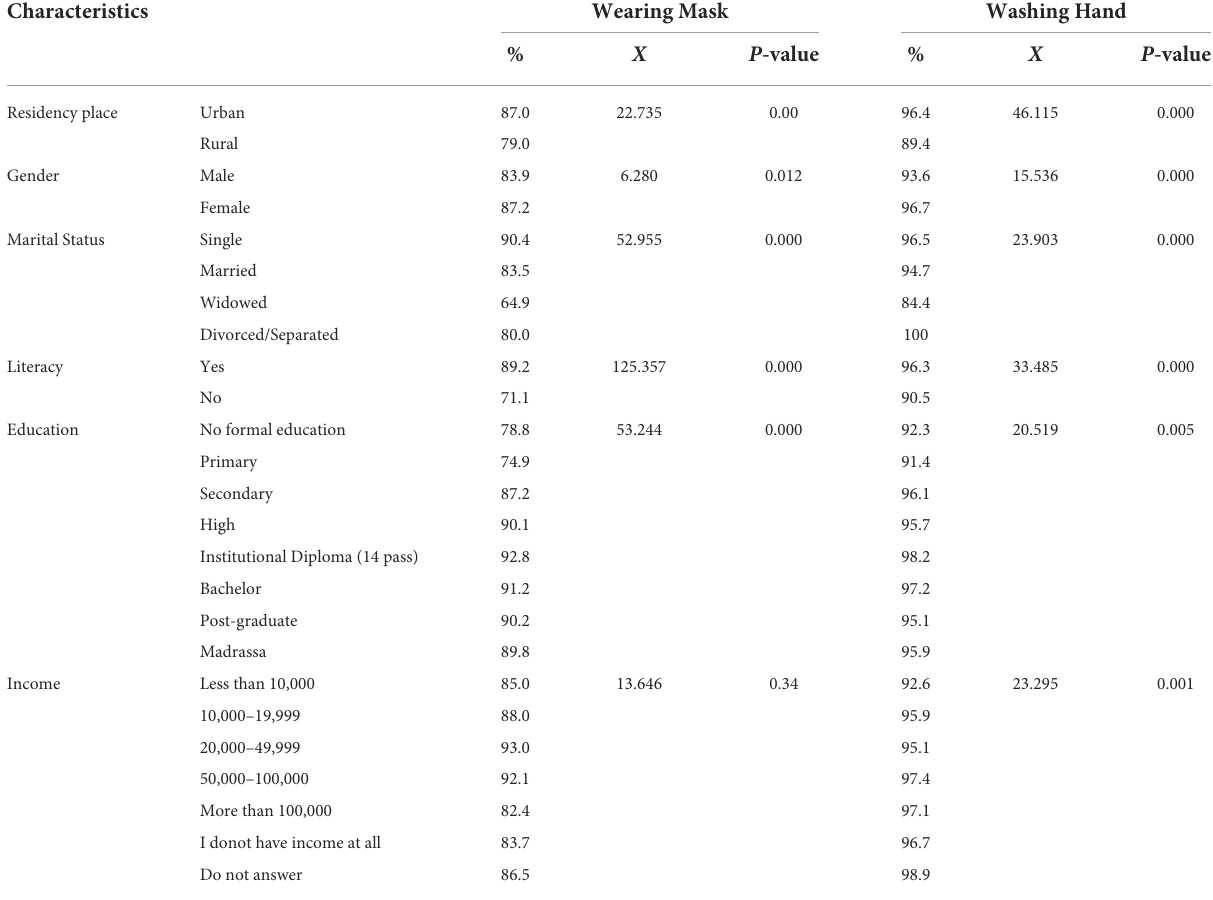
TABLE 7 Practice score of COVID-19 by demographic